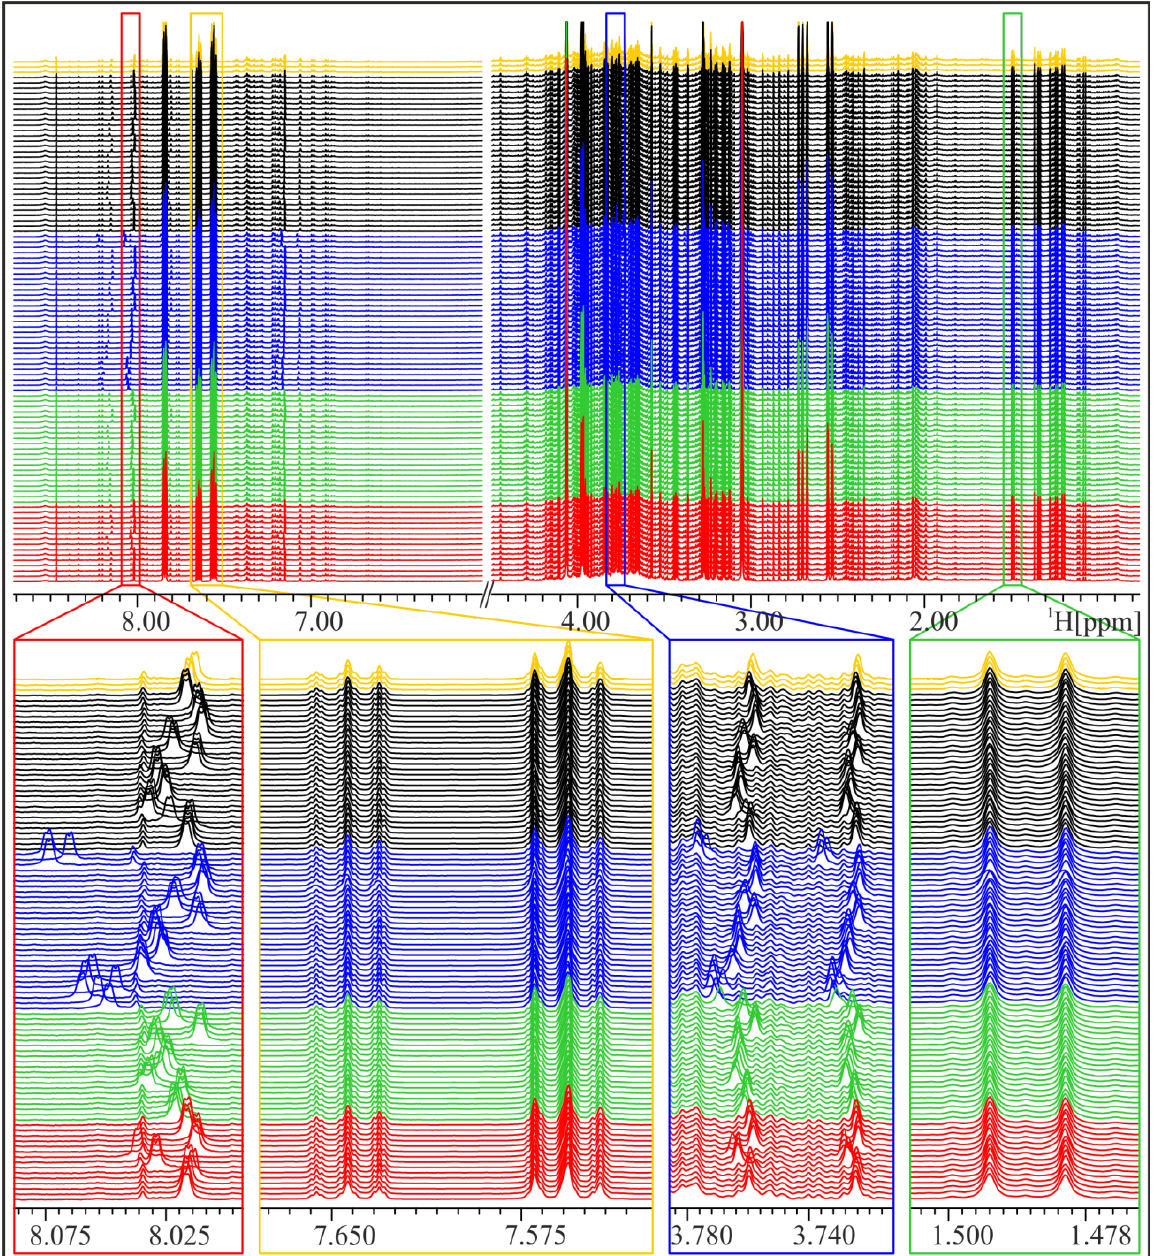
Figure 1. NMR spectra of a spot urine sample of a female subject, frozen and stored under different conditions. Upper panel: overview of whole NMR spectra—urea and water region excluded—demonstrating overall good reproducibility. Lower panels: zoom into relatively constant regions and variable regions with shifted